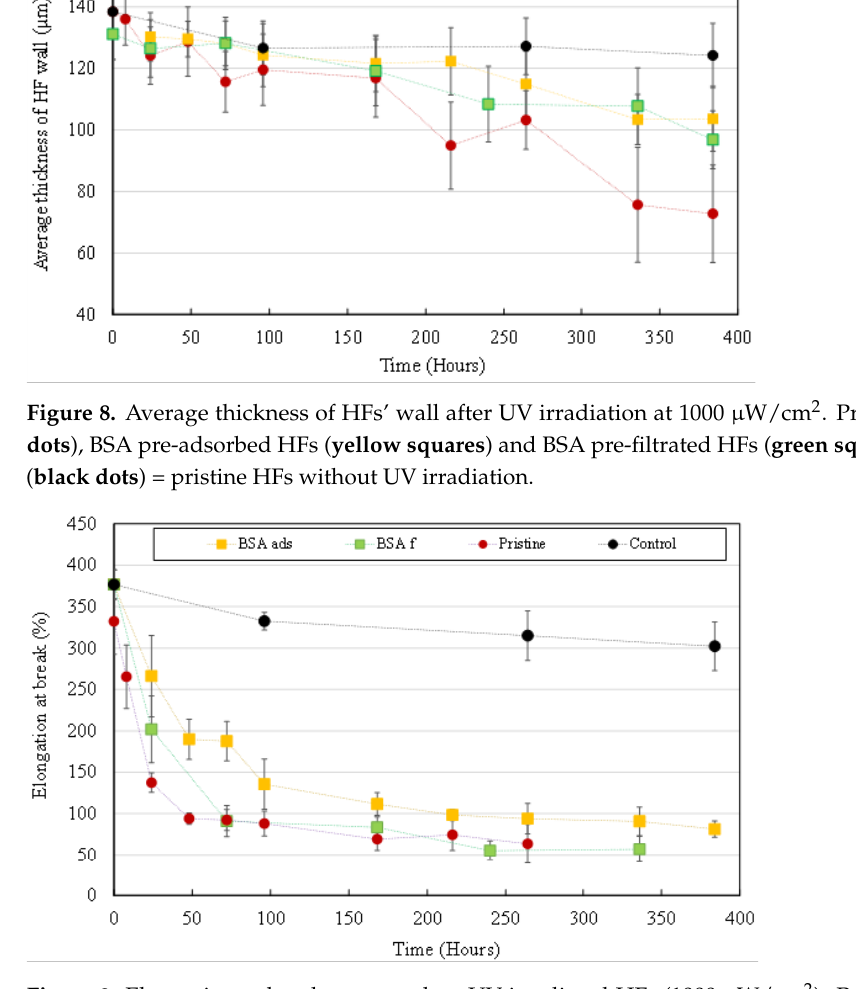
Figure 9. Elongation at break measured on UV irradiated HFs (1000 µW/cm²). Pristine HFs ( red dots ), BSA ads HFs ( yellow squares ) and BSA f HFs ( green squares ). Control ( black dots ) = pristine HFs without UV irradiation.